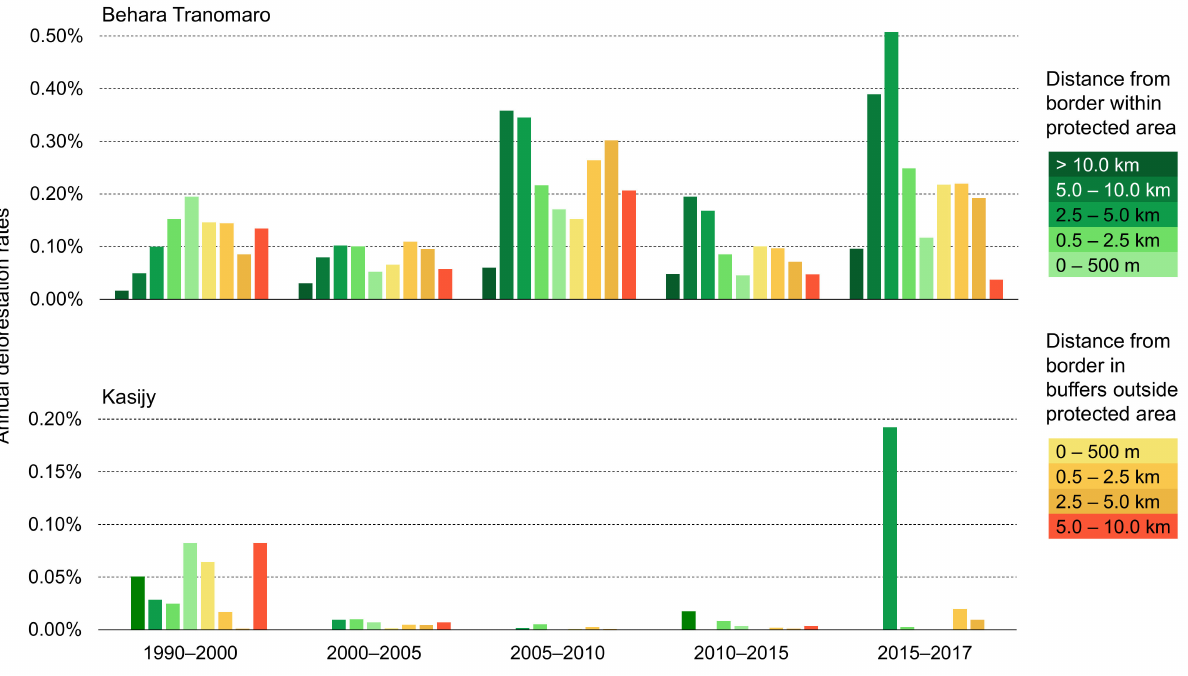
Figure 6. Annual deforestation rates in the two smaller case study sites and their buffers according to their distance to PA borders. (pattern as in Figure 1; note that the y axe has scale/10 as compared to scales in Figure